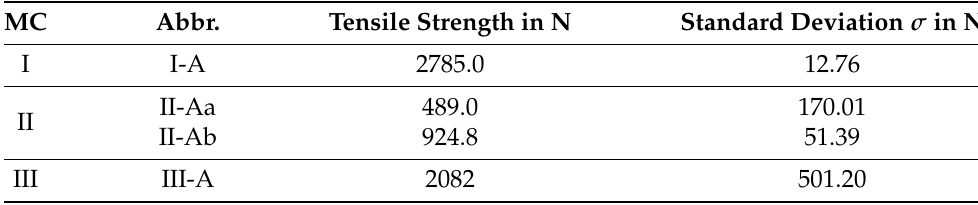
Table A4. Lap shear test results for all adhesively bonded